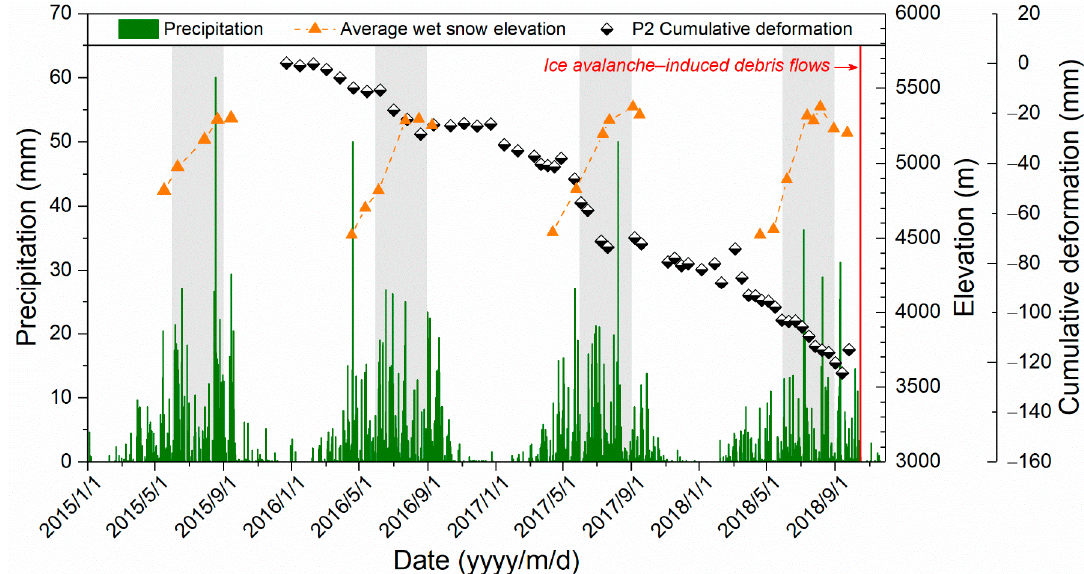
Figure 9. The precipitation, cumulative deformation, and average wet snow elevation before the Sedongpu ice avalanche-induced debris flows occurred. The location of P2 is shown in Figure 3. The gray shading indicates the duration of the rainy season in the basin, and the red line indicates the date of the occurrence of the ice avalanche-induced debris flows.